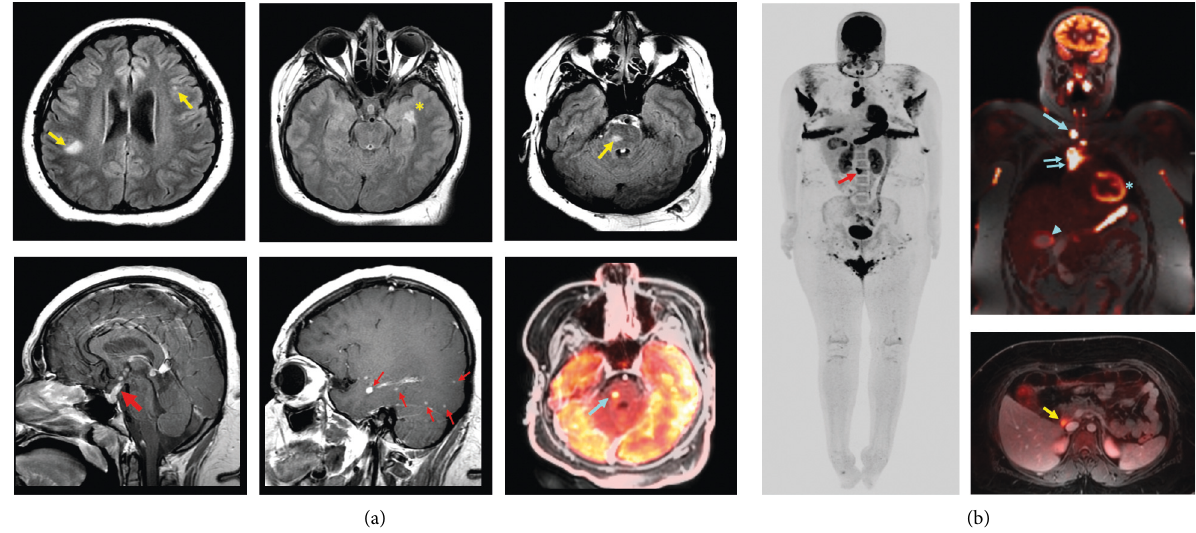
Figure 1: Disease status prior to intervention with 2CdA. (a) Brain MRI: multiple focal lesions are seen at the subcortical white matter and brainstem (yellow arrows), cerebellum (not shown), and left mesial temporal lobe/amygdala ( ∗ ) on T2 FLAIR imaging. Enhancing soft tissue is also seen at the pituitary stalk extending into the sella (big red arrow). Additional enhancing nodules (small red arrows) are seen in the brain. Corresponding abnormal FDG uptake (teal arrow) is also demonstrated from a brain image in the whole-body PET-MRI. (b) Whole- body PET MRI: multiple foci of abnormal FDG activity are seen in the neck, including the right thyroid (long teal arrow) and in the mediastinum along the thymic tissues (double teal arrows). Diffuse mucosal thickening of the gastric wall ( ∗ ) and gallbladder wall (ar- rowhead) with FDG-avidity also suggested possible XD involvement and/or inflammation. Enlarged and FDG avid portocaval lymph node (yellow arrow) and involvement of the vertebral body (red arrow) were also